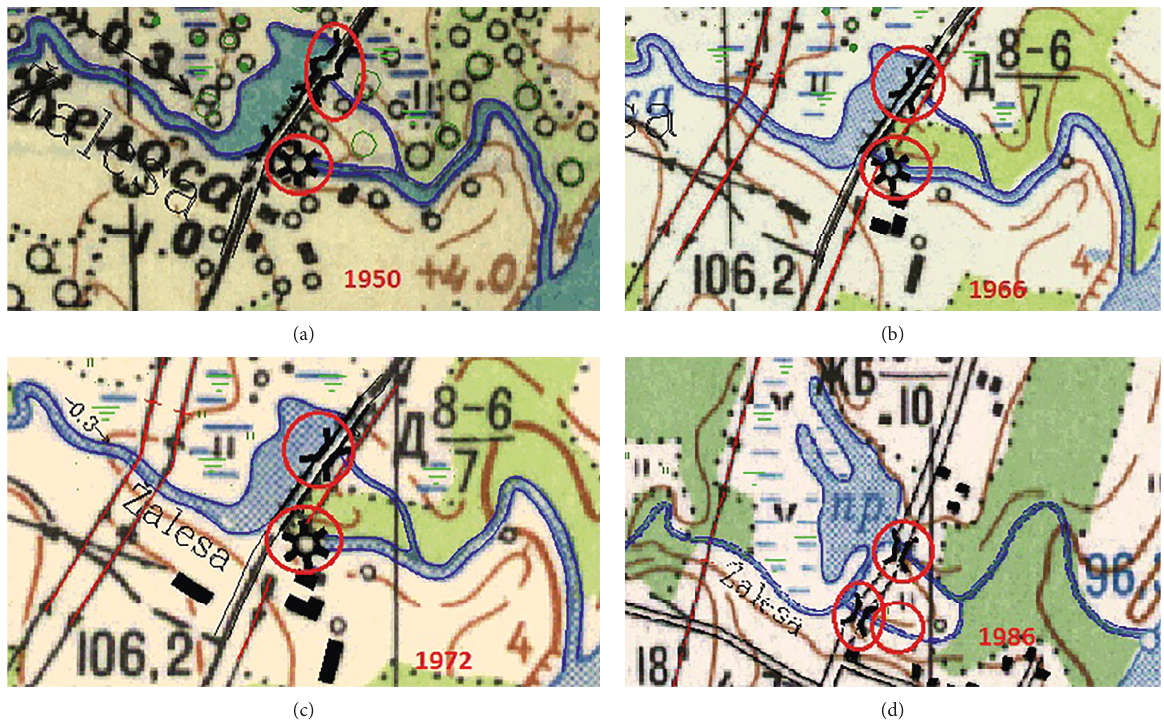
Figure 10: Signs of land drainage, urbanization in the old topographical maps (source: http://www.geoportal.lt).